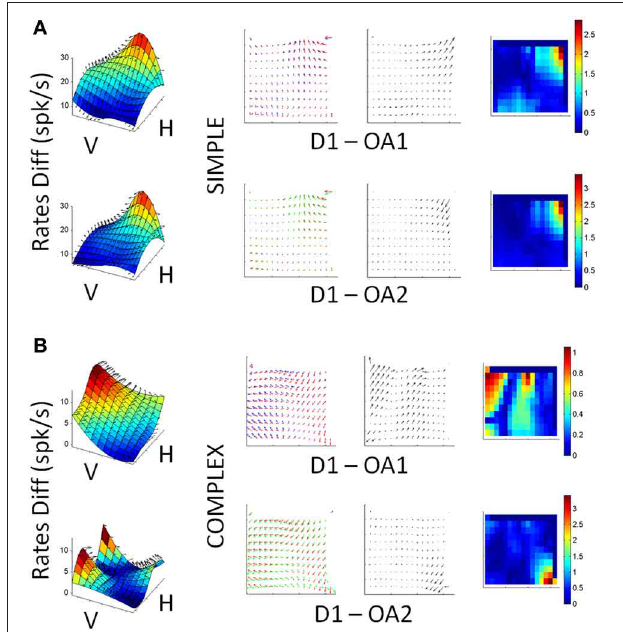
FIGURE 9 | Single cell responses during changes in arm posture. (A) Cell showing relatively simple scaling changes with arm posture and speed learning during OA1 and OA2. First column (left to right): Surfaces constructed from the mean firing rate differences between D1 and OA1 (top) and D1 and OA2 (bottom), as a function of board location. Second column: superimposed gradient fields from D1 and OA2, which were used to obtain the Lie Bracket (see Materials and Methods). The resulting residual vector field (third column) is plotted next to a color map of the magnitude of the residual Lie Bracket field (last column). (B) Responses of a more complex cell, in the same format as (A) where the field rotates and scales with the changes in posture and speed learning from D1 to OA1, then stabilizes in